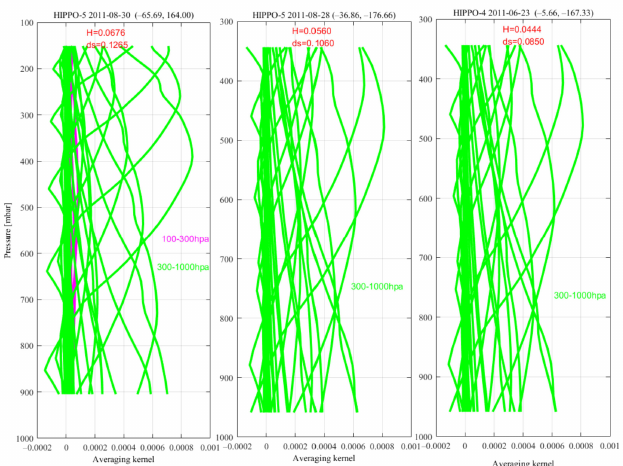
Figure 15. Examples of AKs for the measurements over tropical (left), mid-latitude (middle), and high- latitude (right)